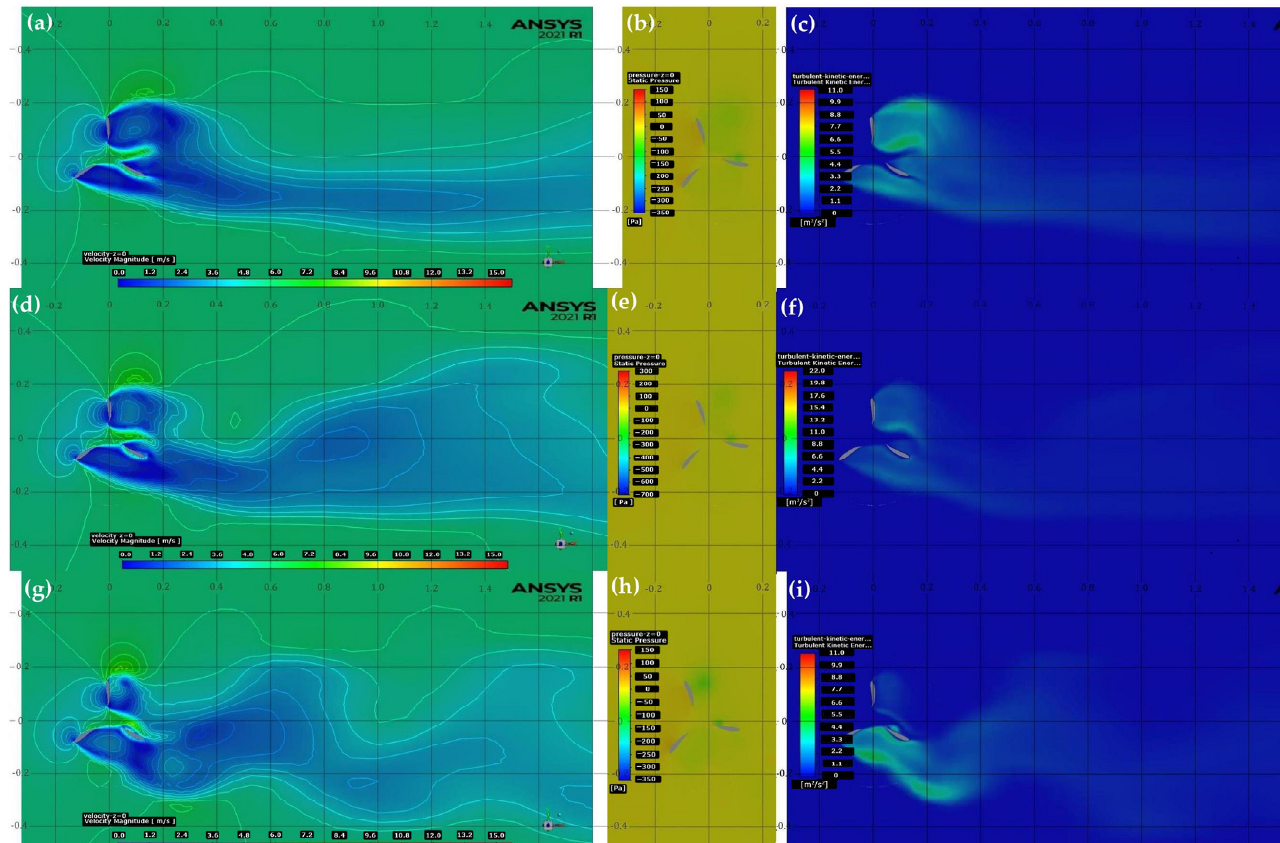
Figure 16. Contours for Savonius three-blade turbine at wind speed 6 m/s of: ( a ) Velocity at TSR of 0.05; ( b ) Pressure at TSR of 0.05; ( c ) TKE at TSR of 0.05; ( d ) Velocity at TSR of 0.10; ( e ) Pressure at TSR of 0.10; ( f ) TKE at TSR of 0.10; ( g ) Velocity at TSR of 0.20; ( h ) Pressure at TSR of 0.20; ( i ) TKE at TSR of 0.20.